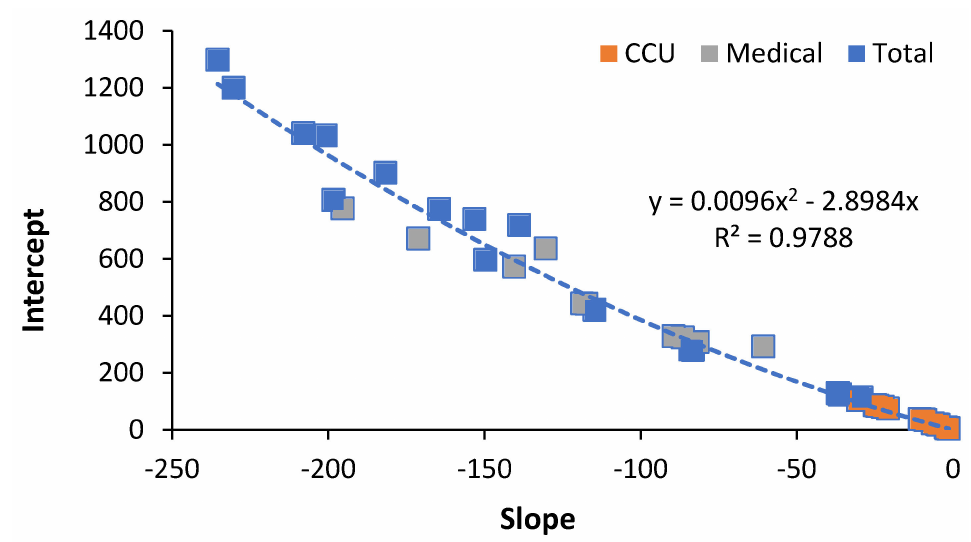
Figure 1. Relationship between slope and intercept for hospital bed numbers (critical care, medical or total beds) in world countries. Data are from three previous studies